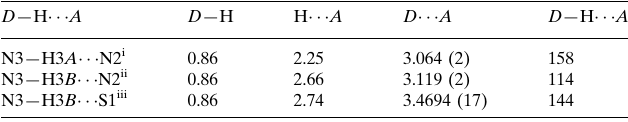
Hydrogen-bond geometry (A˚ , (cid:3)